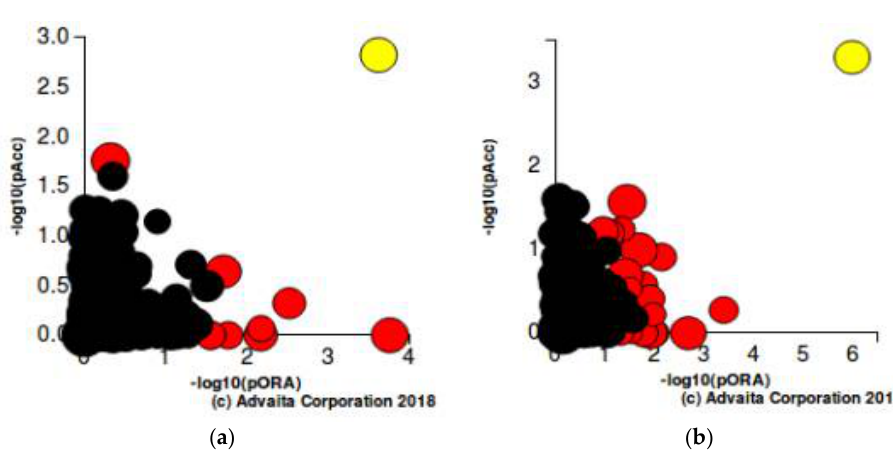
Figure 5. Perturbation (y-axis) vs. Overrepresentation (x-axis) reveals disrupted pathways: ( a ) At 24 h of JQ1 treatment; ( b ) At four hours of Dexamethasone treatment. The size of each dot denotes the number of genes in the pathway. The x-axis measures p -values obtained using the classical over-representation analysis (pORA). The y-axis represents the p -values obtained from total perturbation accumulation (pAcc) in the pathway. Yellow: Cytokine-cytokine receptor interaction pathway, Red: Significantly enriched pathways, Black: Non-significantly enriched pathways. Table 5. Statistically significant altered pathways (Resistant vs. Sensitive)